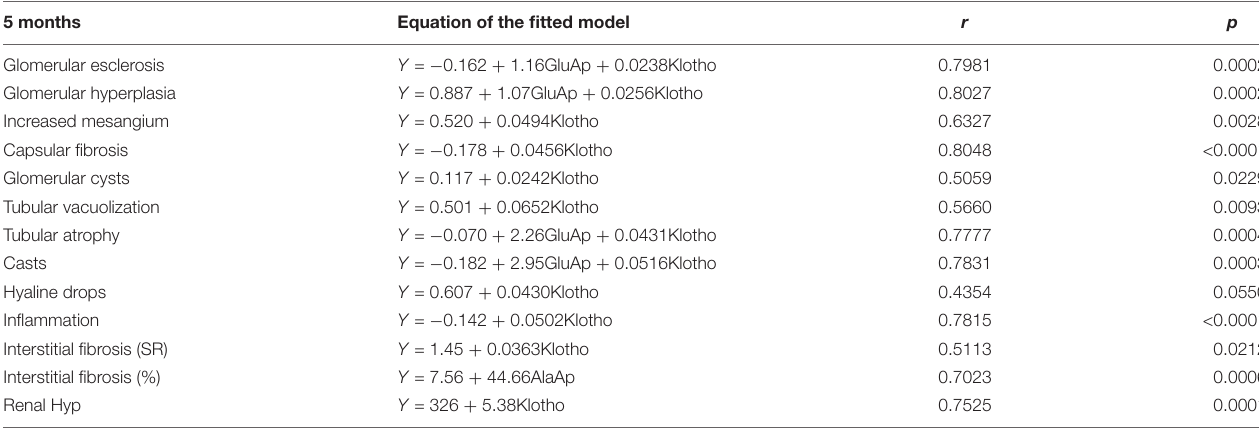
TABLE 6 | Equation of the fitted model, correlation coefficient ( r ) and p -value of the multiple linear regression between urinary markers measured at 5 months and renal lesions at the end of the experiment (8 months old) in Zucker lean and Zucker obese rats ( n = 20).